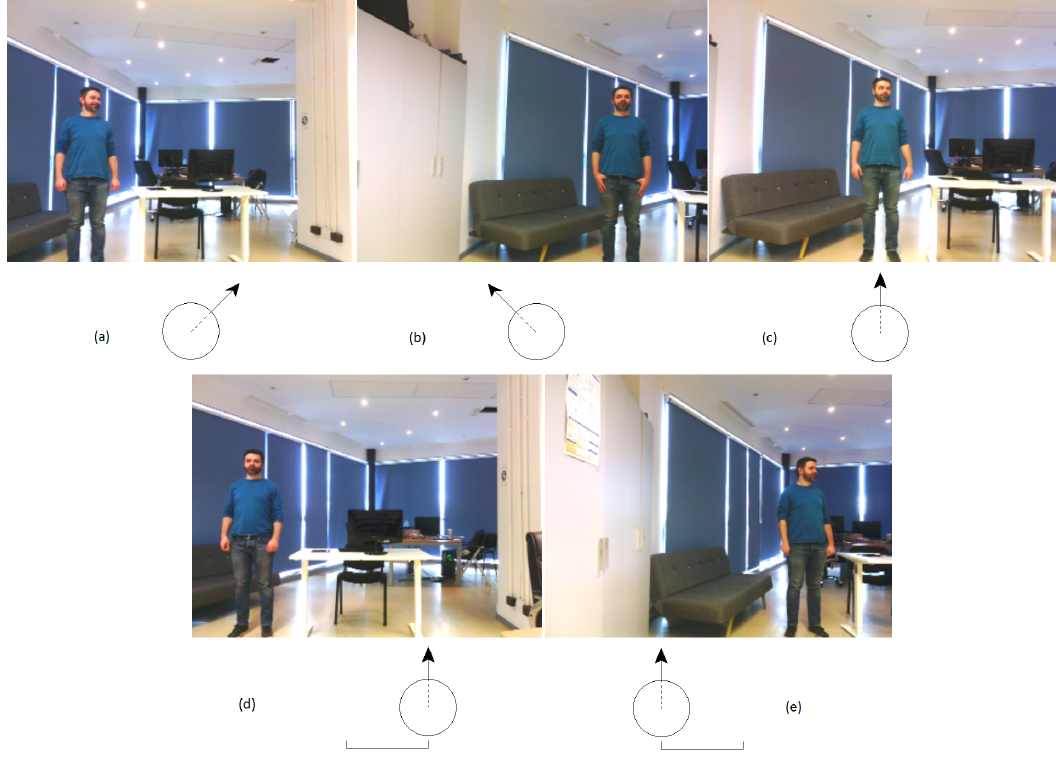
Figure 10. Sensors positions used in the